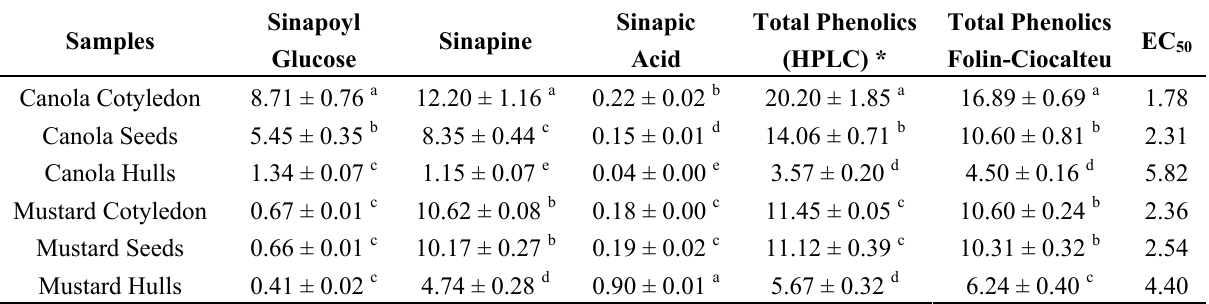
Table 1. Profile of sinapic acid and its derivatives in different fractions of mustard and canola with their EC 50